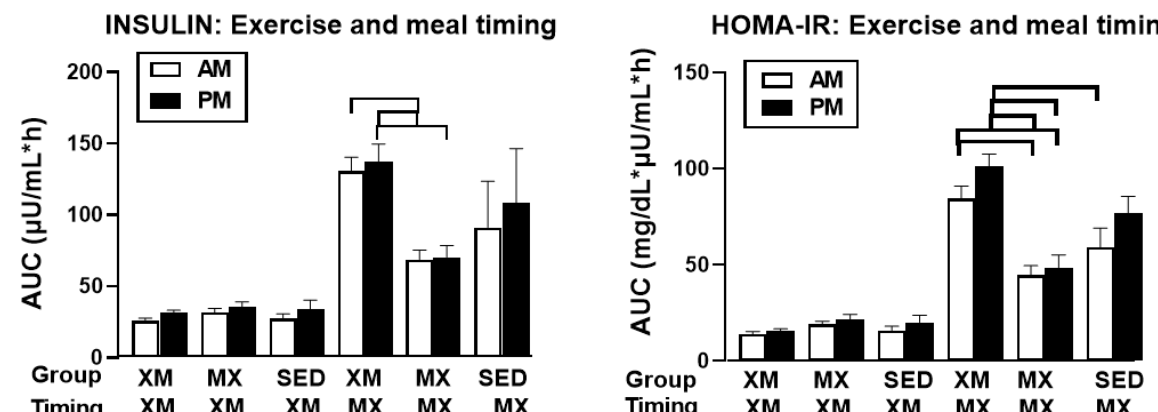
Figure 7. Exercise- and meal-timing effects on insulin AUCs ( left ) and HOMA-IR AUCs ( right ). Both the morning and afternoon XM insulin AUCs were higher than the AM MX AUC. Afternoon MX insulin UC also was significantly higher than the PM MX AUC ( left panel). Both the morning and afternoon XM HOMA-IR AUCs were significantly higher than the AM and PM MX AUCs. Evening XM HOMA-IR AUC also was significantly higher than the AM SED AUC ( right panel). Brackets identify groups with significant between- and within-group differences. EX = exercise, XM = exercise before meals, MX = exercise after meals, SED = sedentary group.